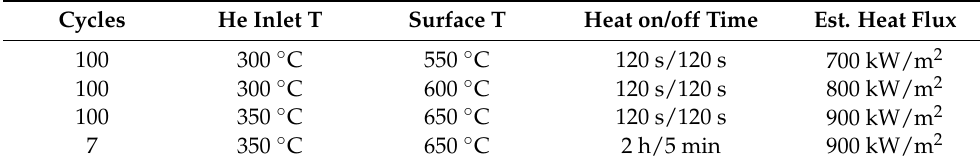
Figure 8. Thermal image of the FG mock-up by the IR camera. The red rectangle marks the coated area and the red and blue cross marks the position of the hottest and, respectively, the coldest point on the coating. The coolant at 300 ◦ C enters the target from the right side and flows to the left side. Table 5. Test matrix for the ODS